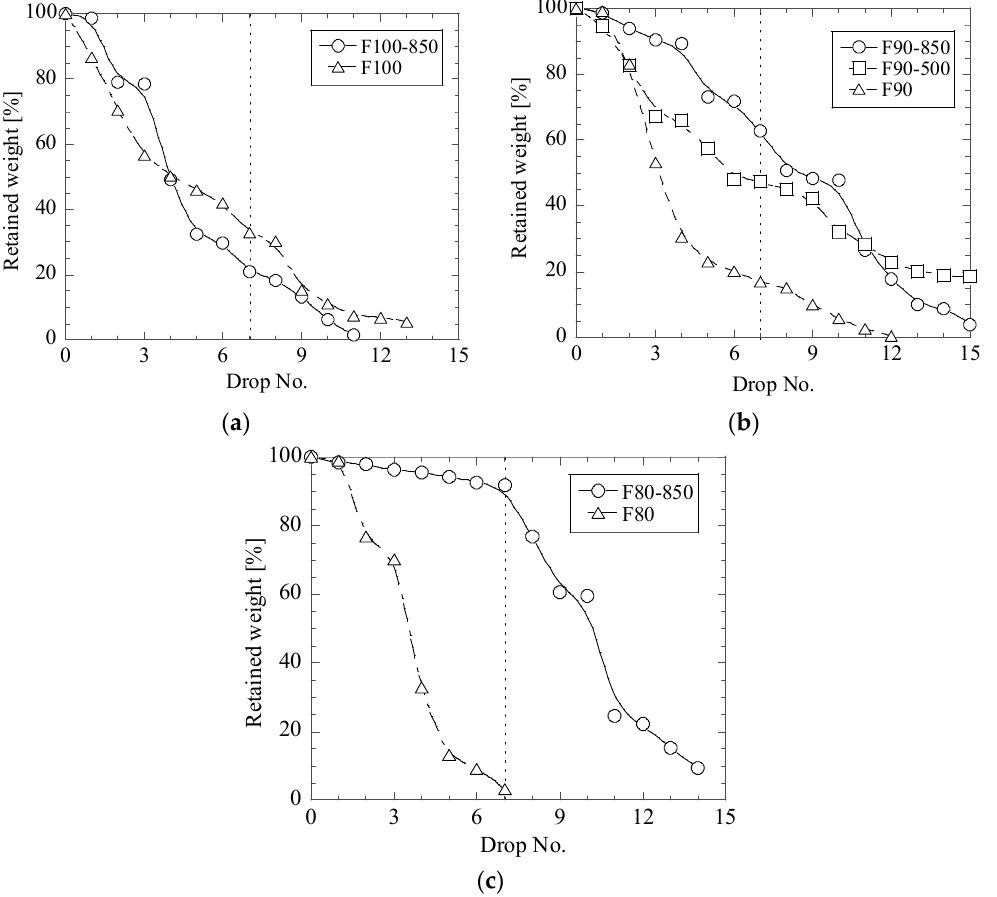
Figure 7. Relationships between retained weight of briquettes F100 ( a ), F90 ( b ) and F80 ( c ) and drop number in drop test trials for different fly ash briquettes before and after heat treatment at 500 °C and 850 °C.